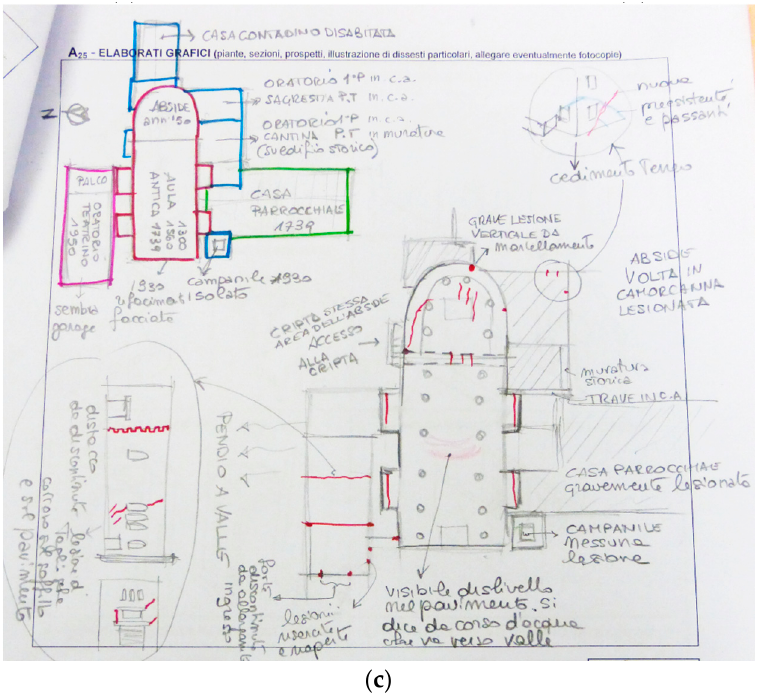
Figure 2. Example of a damage survey of a church struck by the 2016 seismic event: ( a ) vertical crack in the apse in correspondence to a perpendicular wall situated at the back; ( b ) diagonal cracks in the sacristy corner; and ( c ) the church survey form reporting the volumetric stratigraphy and the crack pattern sketches.